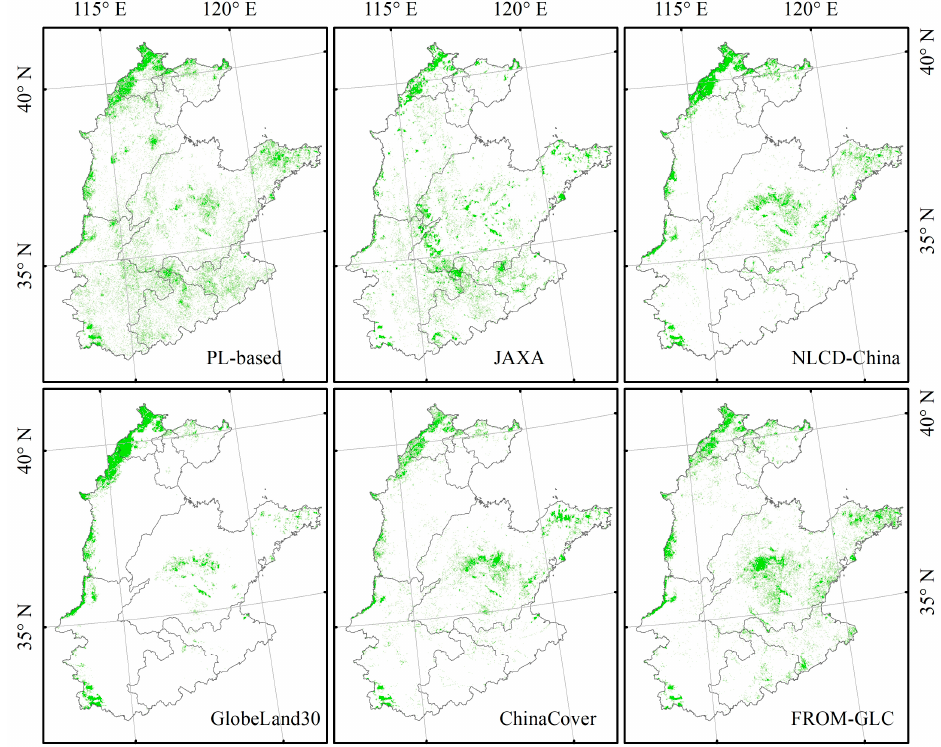
Figure 5. Spatial distributions of the PL-based and other five forest maps.